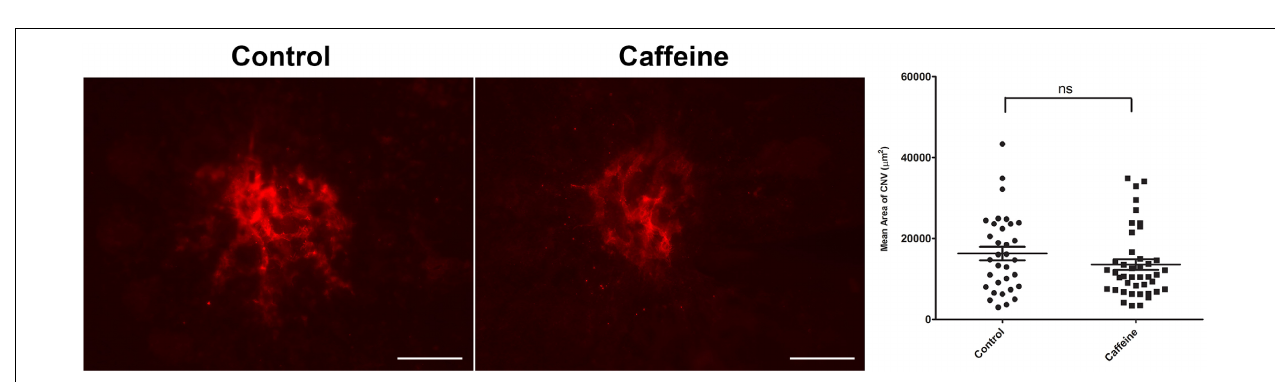
FIGURE 8 | Caffeine treatment reduces macrophage accumulation. Mice (2-month-old C57BL/6j male and female) received caffeine 20 mg/kg first dose and 10 mg/kg subsequent doses or vehicle starting 5 days prior to laser by gavage. Treatments continued until RPE/choroid was harvested 6 days later and stained with anti-F4/80. The degree of macrophage recruitment was assessed as detailed in Methods. Scale bar = 200 µ m (**** p < 0.0001; n = 10 mice/group).